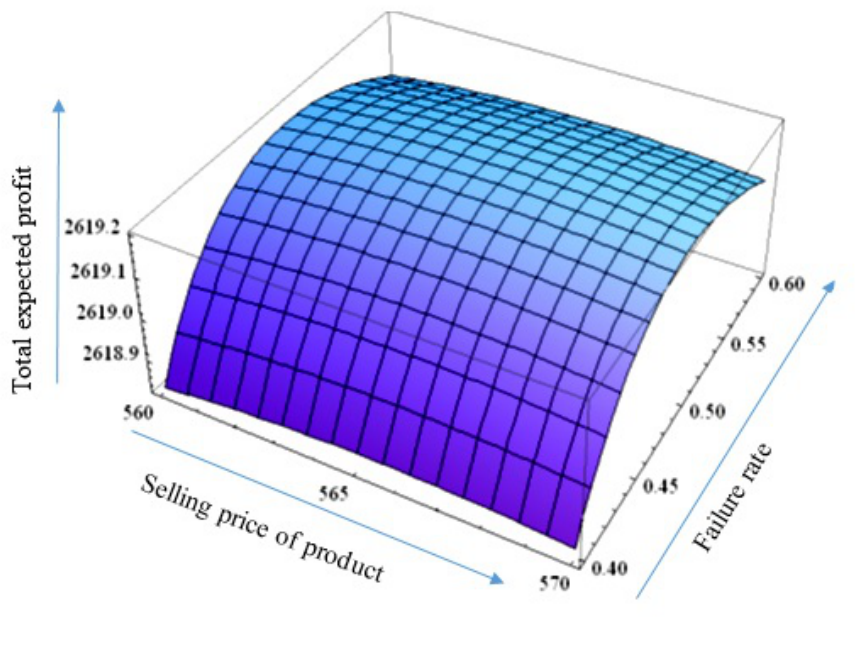
Figure 7. The total expected profit versus the advertising variable quantity and failure rate α of two